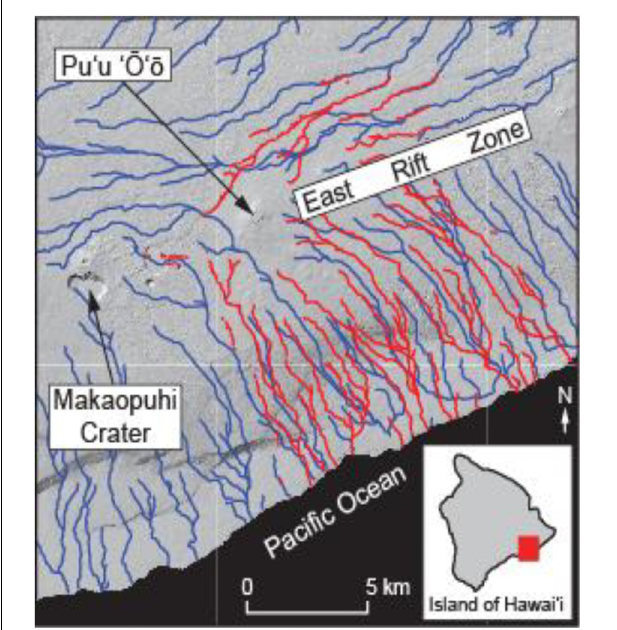
FIGURE 3 | Steepest descent lines indicating likely lava flow paths during the 1983–2018 Pu’u ’O’o-Kupaianaha eruption along K¯ılauea’s middle East Rift Zone. Blue lines show paths based on topographic data from 2005, whereas red lines are flow paths that were updated in 2013 using topographic information derived from bistatic TanDEM-X SAR